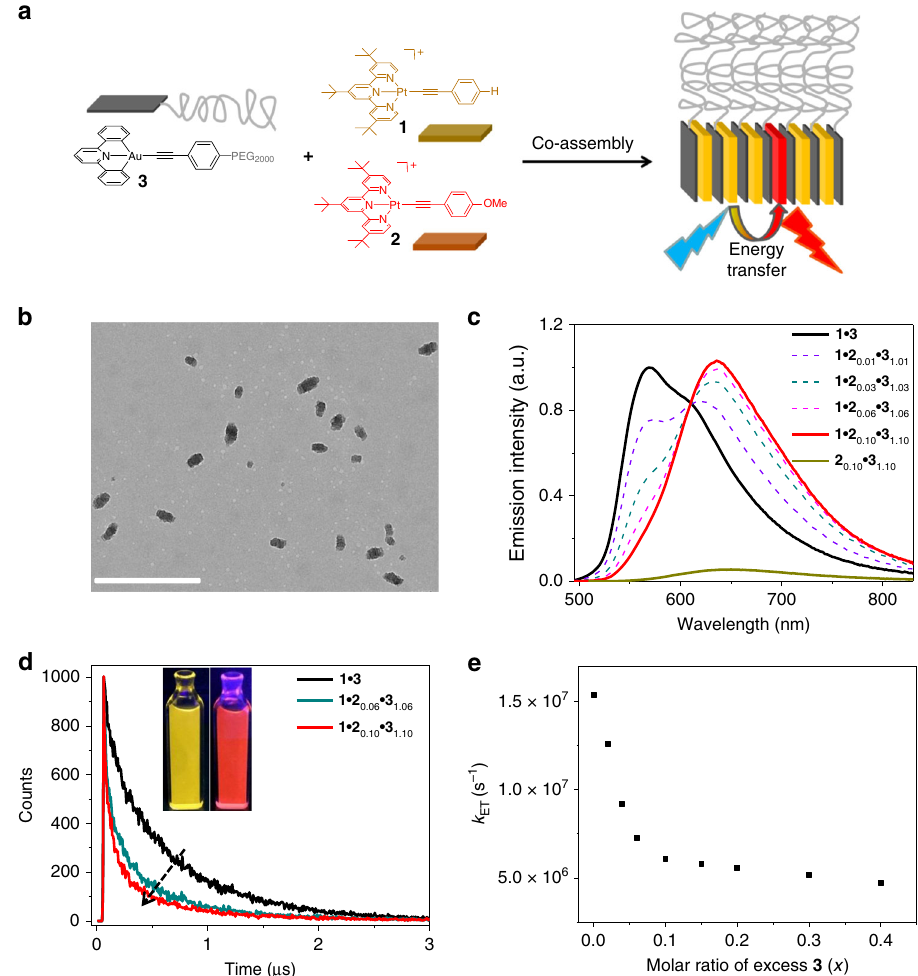
Fig. 6 Characterization of co-assembled system from 1 (cid:129) 2 (cid:129) 3 . a Schematic representation for the triplet energy transfer of the ternary complex 1 (cid:129) 2 (cid:129) 3 in aqueous medium. b Transmission electron microscopic image recorded on a copper grid by drop-casting complex 1 (cid:129) 2 0.1 (cid:129) 3 1.1 [ 1 : 5.00 × 10 − 5 M in water/ MeOH (90:10, v / v )]. Scale bar: 500 nm. c Emission spectra and d emission decay traces for the ternary complex 1 (cid:129) 2 x (cid:129) 3 (1 + x ) [ 1 : 5.00 × 10 − 5 M in water/ MeOH (90:10, v / v ), x varies from 0 to 0.1]. For d , the emission wavelength is chosen at 525 nm, considering that 2 (cid:129) 3 displays negligible emission at the selected wavelength. Inset of d : emission color images of 1 (cid:129) 3 (left) and 1 (cid:129) 2 0.03 (cid:129) 3 1.03 (right) under 365 nm ultraviolet lamp. e Relationship of the energy- transfer rate constant ( k ET ) value in the ternary complex 1 (cid:129) 2 0.1 (cid:129) 3 (1.1 + x ) and the excessive amount of 3 [ 1 : 5.00 × 10 − 5 M in water/MeOH (90:10, v / v ), x varies from 0 to